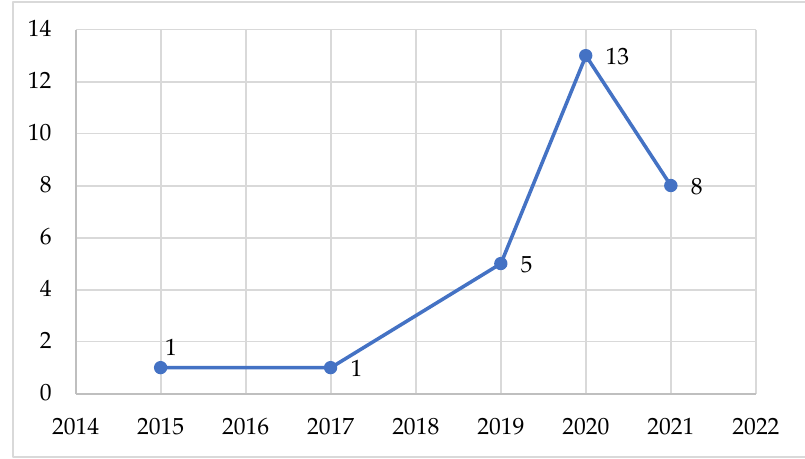
Figure 4. Publication year of the patents/patent applications cited in the text.